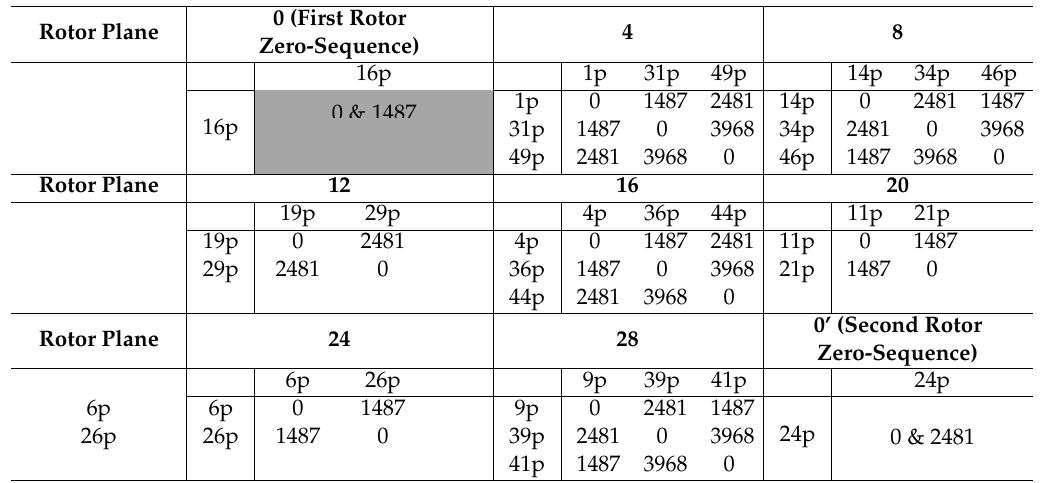
Table 6. Predicted torque pulsating components frequencies for the five-phase IM with 64 bars (in Hz). Sequence “u = 1”.